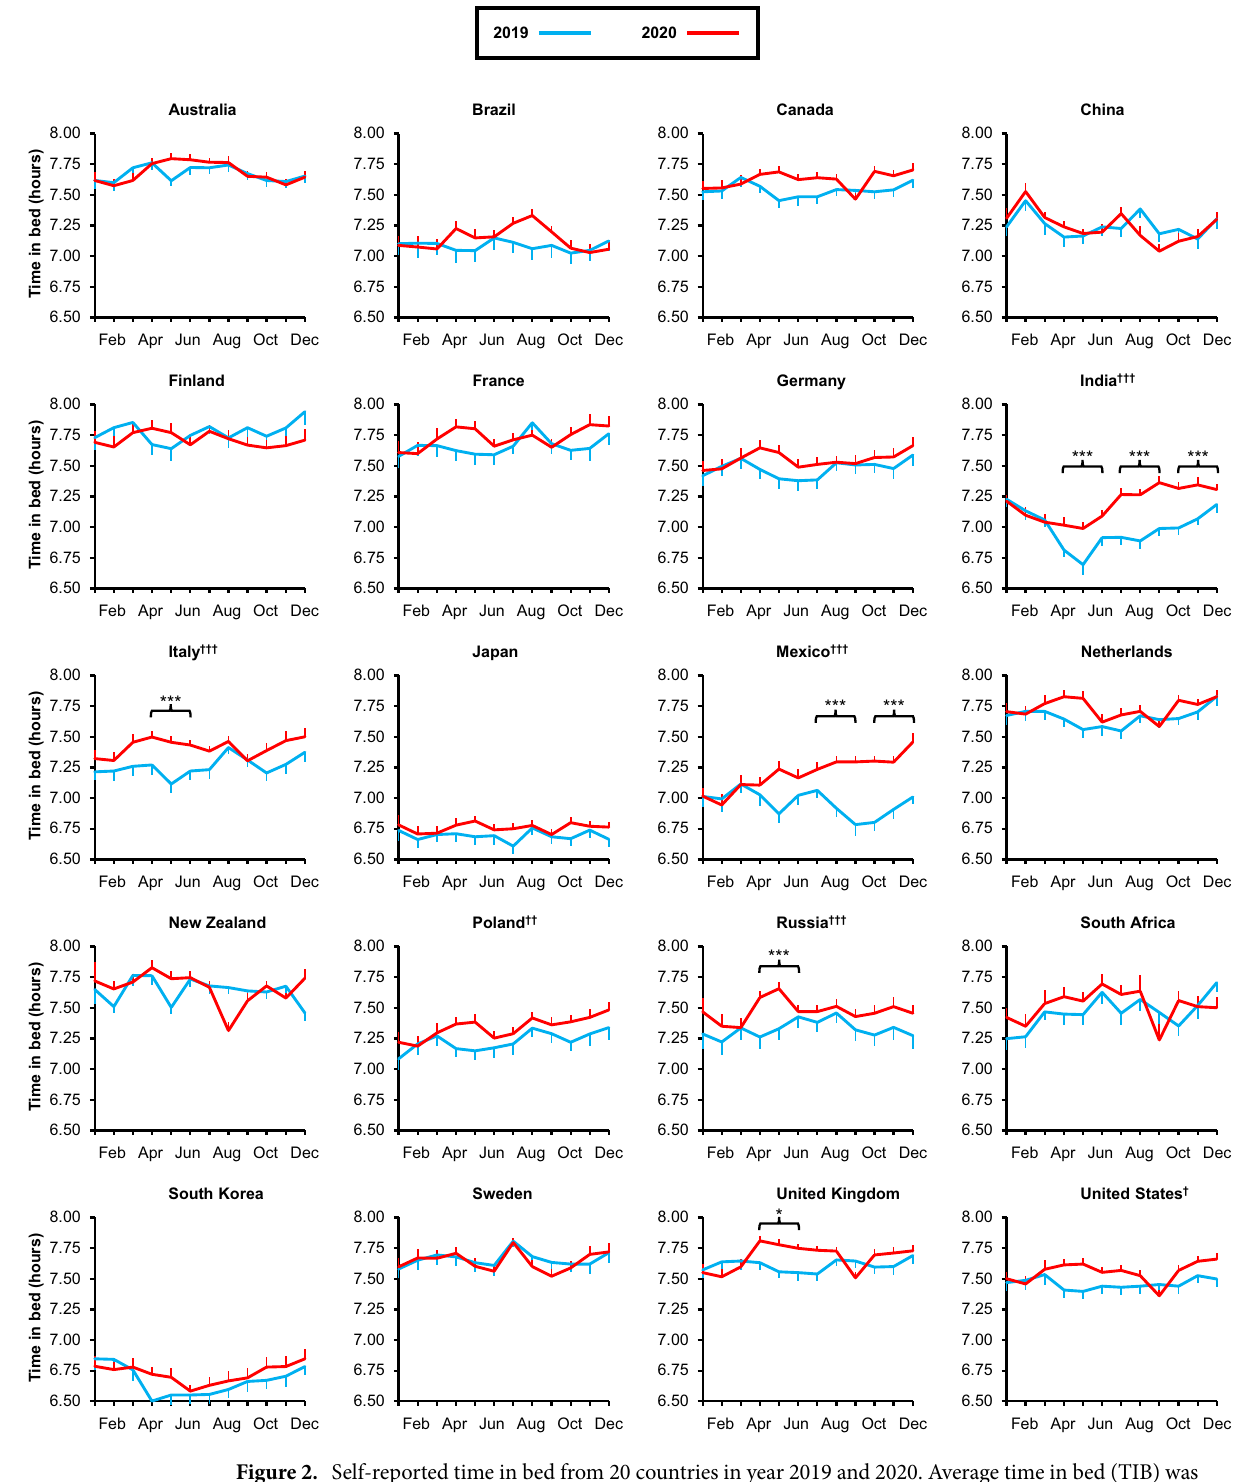
Figure 2. Self-reported time in bed from 20 countries in year 2019 and 2020. Average time in bed (TIB) was calculated from self-reported bed and wake times for each day in 2019 (blue) and 2020 (red) for each country. Bonferroni-adjusted p values comparing average TIB in each quarter of 2019 to the corresponding quarter of 2020 are indicated as follows: * p < 0.05, ** p < 0.01, *** p < 0.001. Bonferroni-adjusted p values comparing overall TIB in 2019 to 2020 is indicated next to each country name as follows: † p < 0.05, †† p < 0.01, ††† p < 0.001. Means ± SEM are